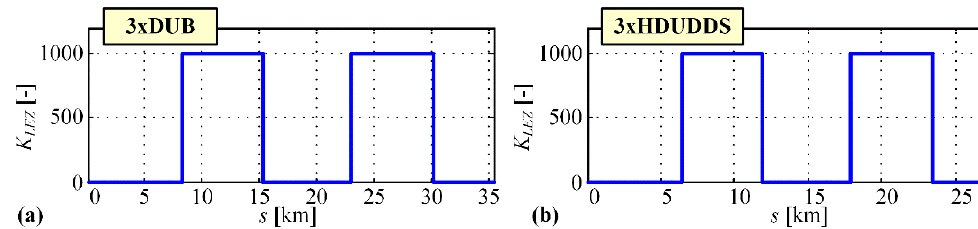
Figure 5. ( a ) Low-emission zones (LEZ) inserted into 3xDUB driving cycle and ( b ) 3xHDUDDS driving cycle, expressed with respect to travelled distance s .